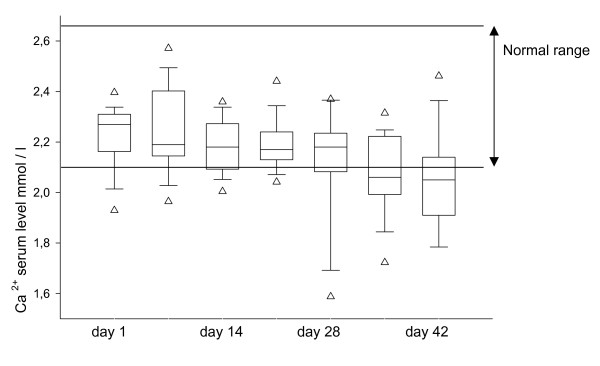
Boxplott of Calcium serum levels. Day 1 after start of therapy to day 42.